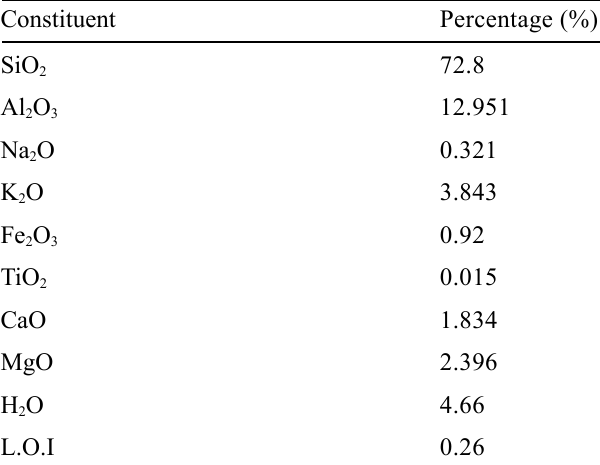
Table 1. The chemical composition of